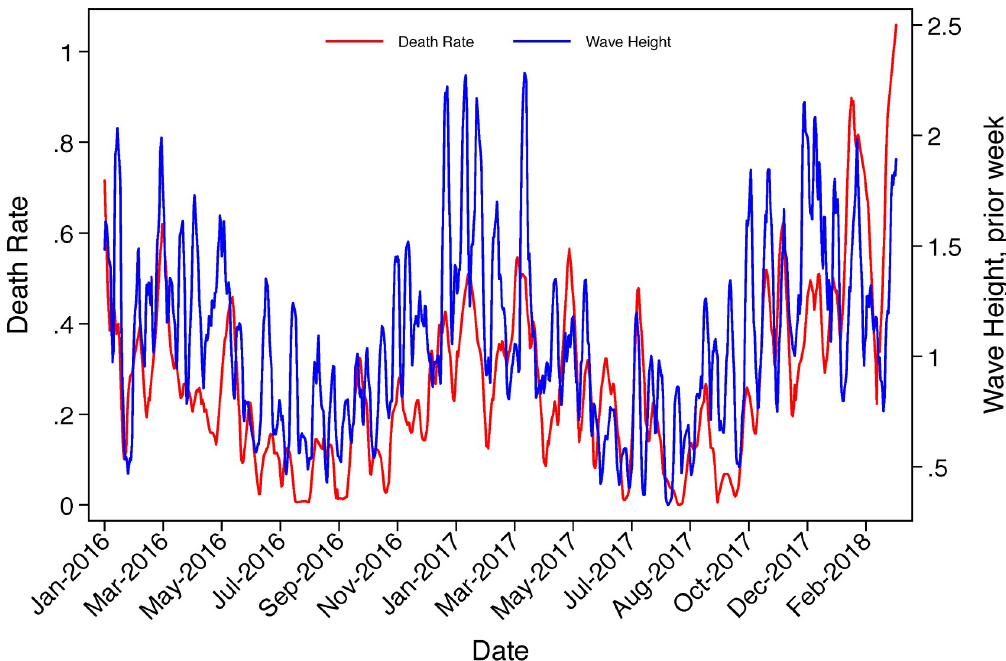
Fig 2. Trends in death rates and Sea conditions during sample period. Daily death rates are calculated using IOM data on migrant deaths and disappearances in the Mediterranean and UNHCR intake data for the Italian coast. Wave heights are drawn from the Copernicus